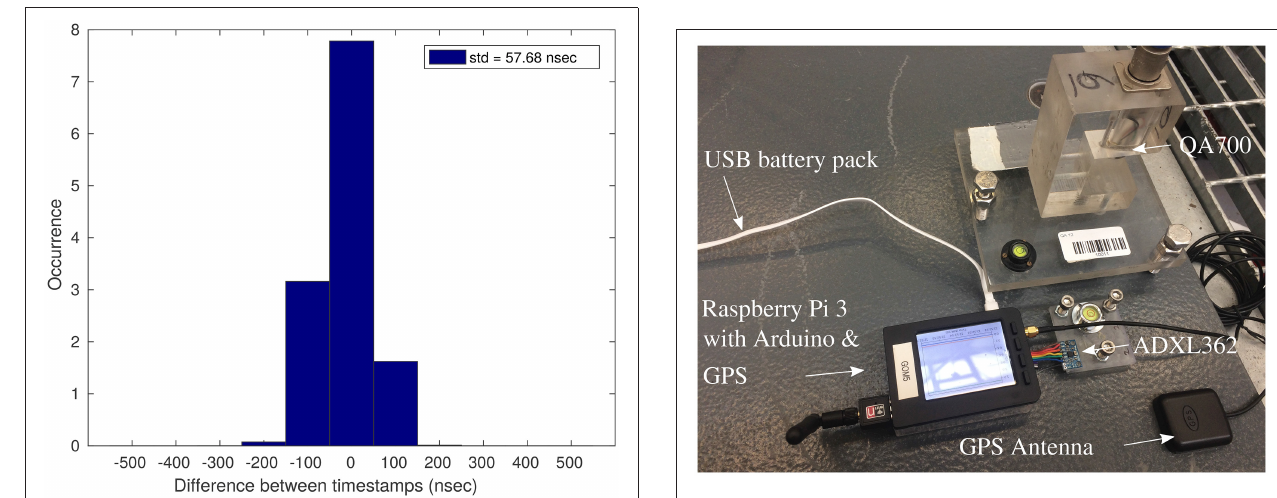
FIGURE 15 | Distribution of time-stamp difference for common trigger signals.